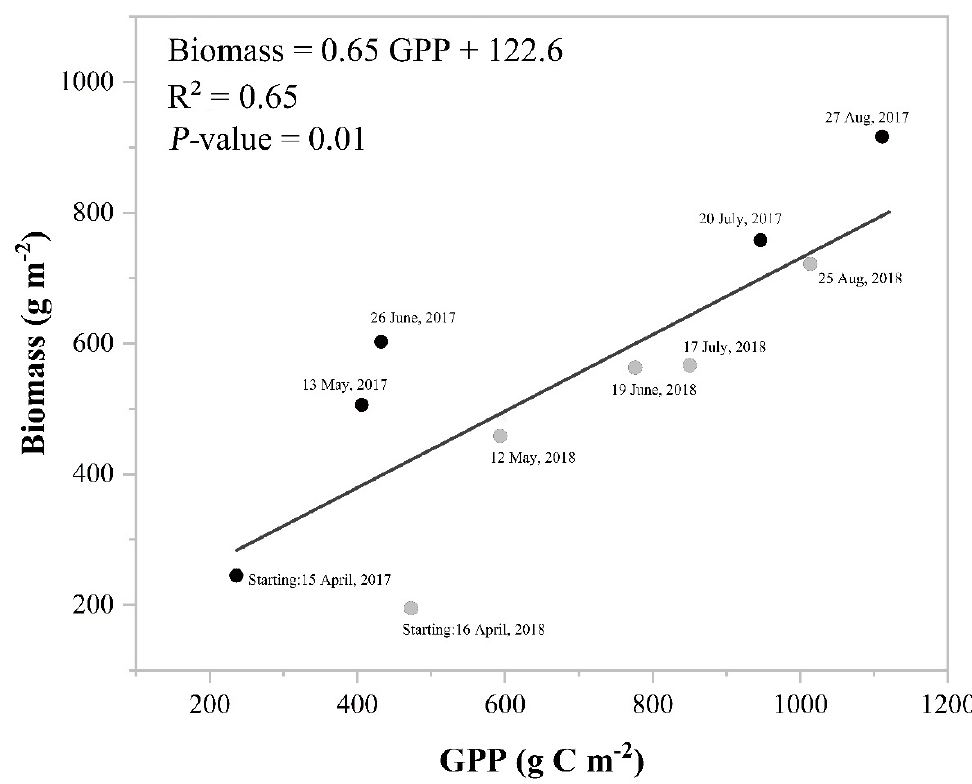
Figure 7. Above-ground biomass yield versus cumulative gross primary production (GPP) from April to August within the 2017 and 2018 growing seasons of a grass-dominated grassland ecosystem located in Middle Tennessee. Table 1. Benchmarking performance of gap-filling artificially created missing net ecosystem exchange (NEE) or latent